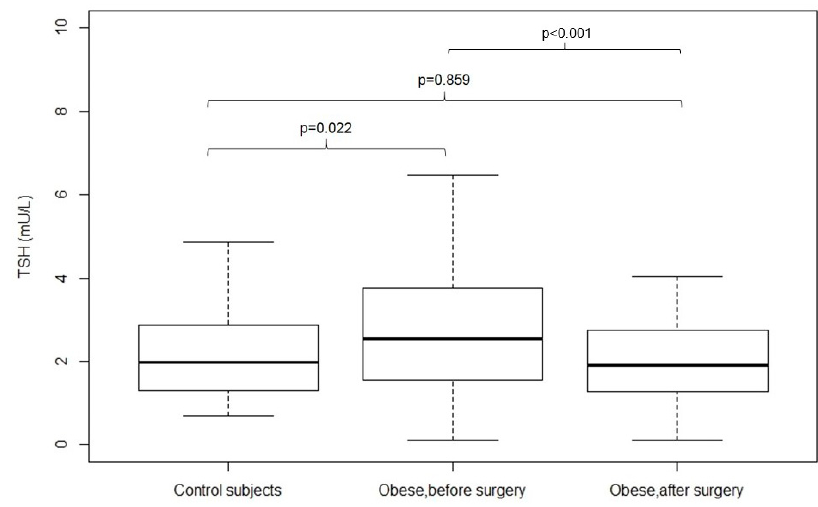
Figure 1. TSH values (median (IR)) in control subjects and obese patient before and 12 months after surgery. Differences were assessed by Student’s t -test for normally distributed data and the Mann-Whitney test was used for comparison of medians. P -values < 0.05 were considered as statistically significant.